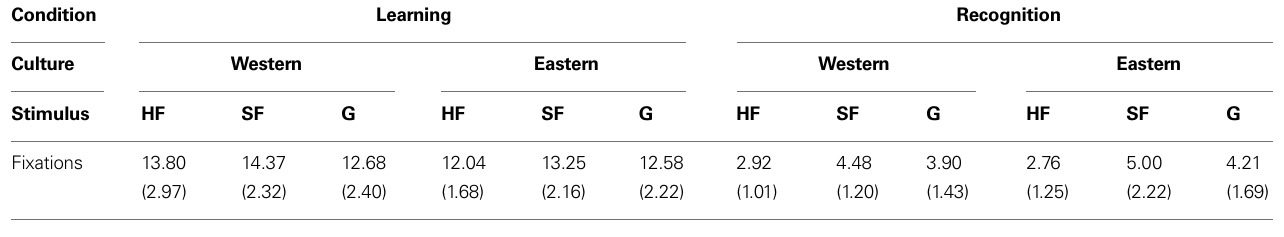
Table 1 | Number of fi xations (standard deviations) for each all stimulus conditions.